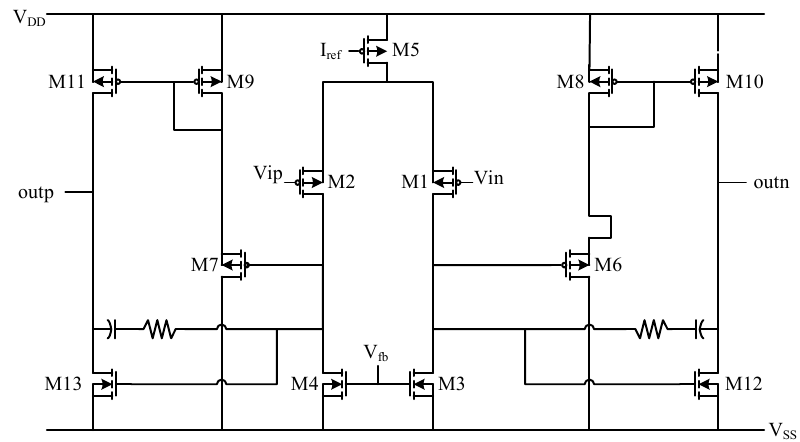
Figure 6. Schematic of transconductance operational amplifier.